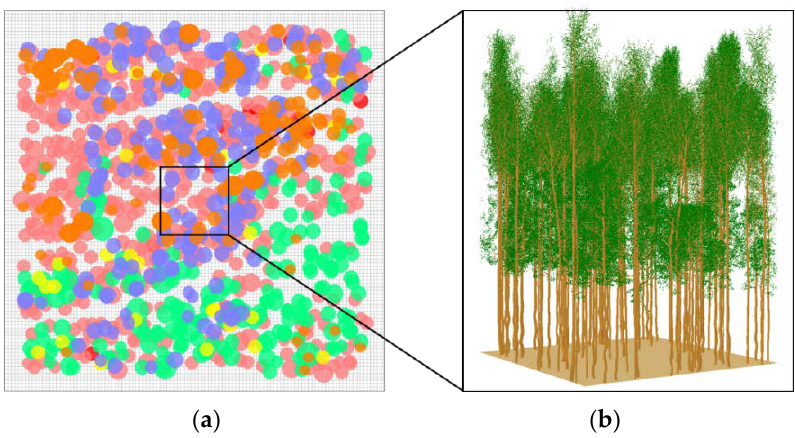
Figure 8. The RAMI scene: ( a ) Two-dimensional (2D) view of the 20 m × 20m subplot, ( b ) 3D view of this subplot.